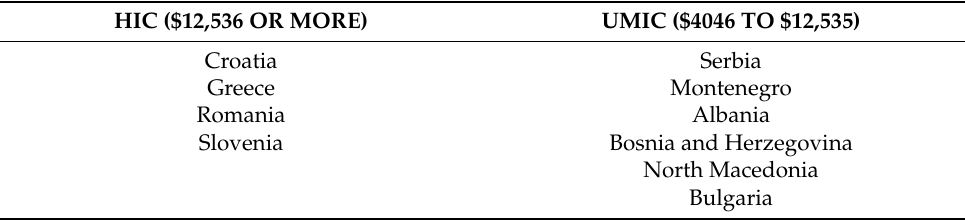
Table A1. World Bank’s official classification of countries by income